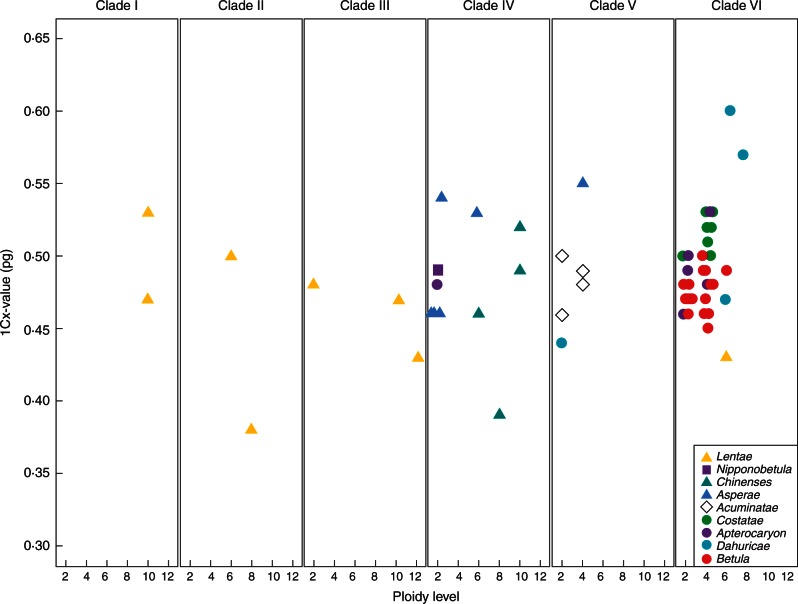
The monoploid genome size (1Cx-value) of Betula species and cytotypes measured from ‘verified’ samples. Ploidy levels were taken from Ashburner and McAllister (2013). Species are grouped according to the clades shown in Fig. 1.